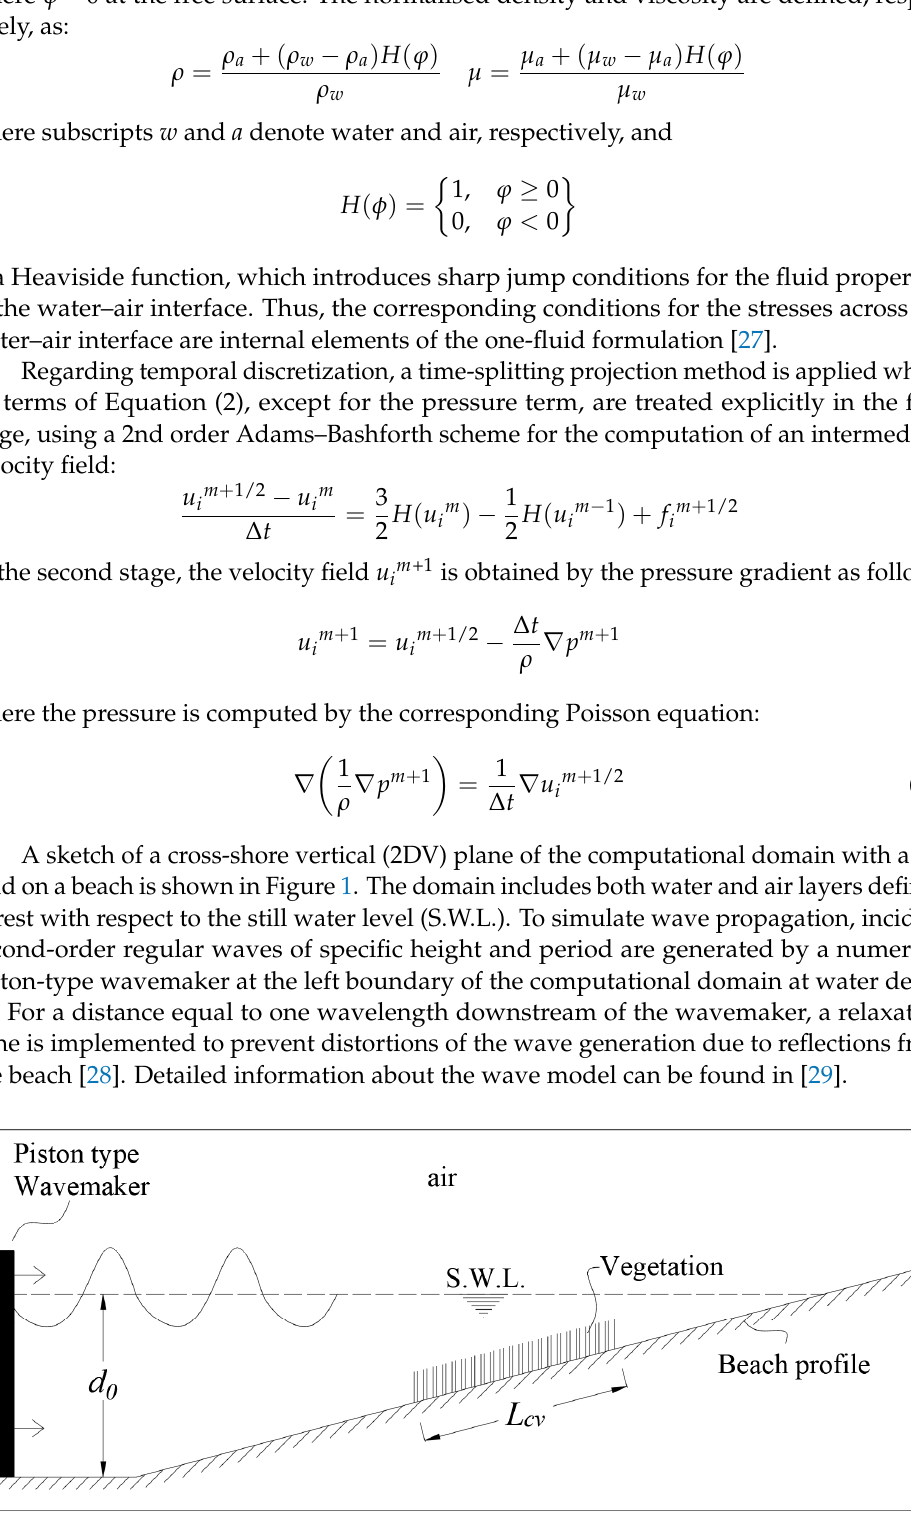
Figure 1. Sketch of the configuration of the computational domain with a CV field.